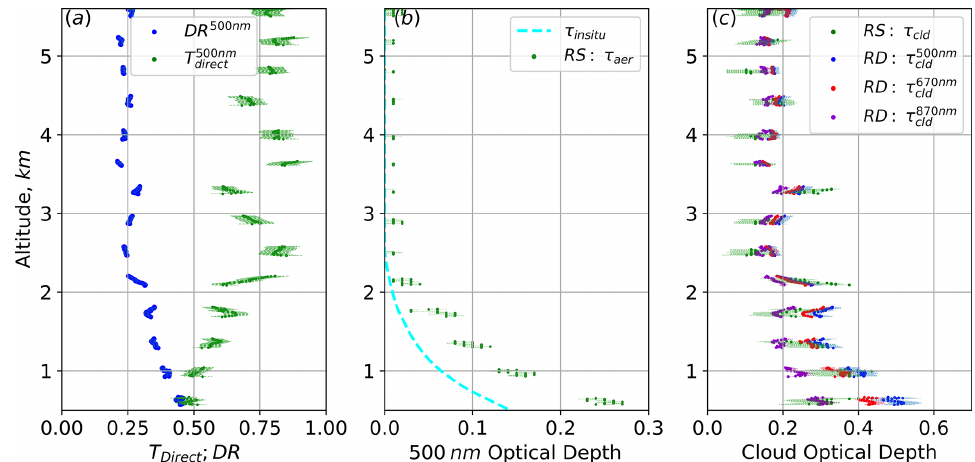
Figure 8. CAMP 2 Ex square spiral on 17 September 2019. (a) DR 500nm mea and T 500nm as a function of P-3 altitude with the associated measurement uncertainty shown by the shading; (b) τ aer profiles derived from RS and in situ; (c) τ cld values for RD at 500, 670, and 870nm and RS as a function of